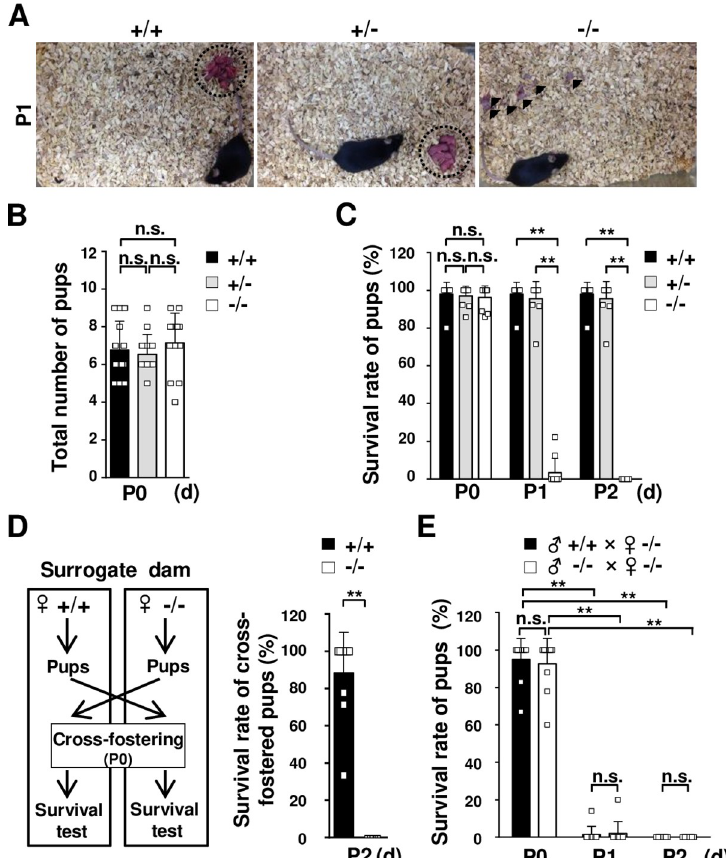
Fig 1. The survival rate of pups born to TDAG51 -/- dams is reduced during the early postpartum period. (A) Survival of pups born to TDAG51 -/- dams. The photographs were obtained on postnatal day 1 (P1). Arrowheads indicate dead pups. Dotted circles indicate pups gathered in a nest. +/+, TDAG51 +/+ dams. +/-, TDAG51 +/- dams. -/-, TDAG51 -/- dams. (B) The average number of pups born to TDAG51 -/- dams. The number of pups per dam was analyzed on P0. Black bar (+/+), TDAG51 +/+ dams. Gray bar (+/-), TDAG51 +/- dams. White bar (-/-), TDAG51 -/- dams. (C) The survival rate of pups born to TDAG51 -/- dams. Pup survival was measured from P0 to P2 in the absence of male mating partners. (D) The survival rate of pups with surrogate TDAG51 -/- dams. A schematic diagram of the cross-fostering experiment between TDAG51 +/+ and TDAG51 -/- dams is shown in the left panel. Pups born to TDAG51 +/+ and TDAG51 -/- dams were interchanged on P0, and the survival of the cross-fostered pups with their surrogate dams was analyzed on P2. Black bar (+/+), TDAG51 +/+ surrogate dams. White bar (-/-), TDAG51 -/- surrogate dams. (E) The effect of male mating partners on the survival of pups born to TDAG51 -/- dams. Pup survival was analyzed from P0 to P2 in the presence of the male mating partner. Black bar, TDAG51 -/- dams with TDAG51 +/+ male mice. White bar, TDAG51 -/- dams with TDAG51 -/- male mice. �� p < 0.01. n.s., not significant. and TDAG51 +/- dam cages ( F = 378, p = 0.97) (Fig 1C). However, the survival rate of the 2, 27 pups in the TDAG51 -/- dam cages was decreased to 3.5 ± 2.4% ( F = 378, p < 0.01) compared 2, 27 to that in the TDAG51 +/+ and TDAG51 +/- dam cages (98.0 ± 2.0% and 95.5 ± 2.9%, respectively) on P1, and no surviving pups were observed in the TDAG51 -/- dam cages on P2 (Fig 1C). To further test the effect of the TDAG51 -/- dams on pup survival, we conducted a pup cross-fos- tering experiment between the home cages of the TDAG51 +/+ and TDAG51 -/- dams. To test the survival rate of the cross-fostered pups, the pups born to the TDAG51 -/- dams were imme- diately transferred to the nests of TDAG51 +/+ surrogate dams on P0, while the pups born to the TDAG51 +/+ dams were transferred to the nests of TDAG51 -/- surrogate dams as illustrated in Fig 1D (left). After 2 days (P2), approximately 88.3 ± 7.0% of the transferred TDAG51 -/- pups